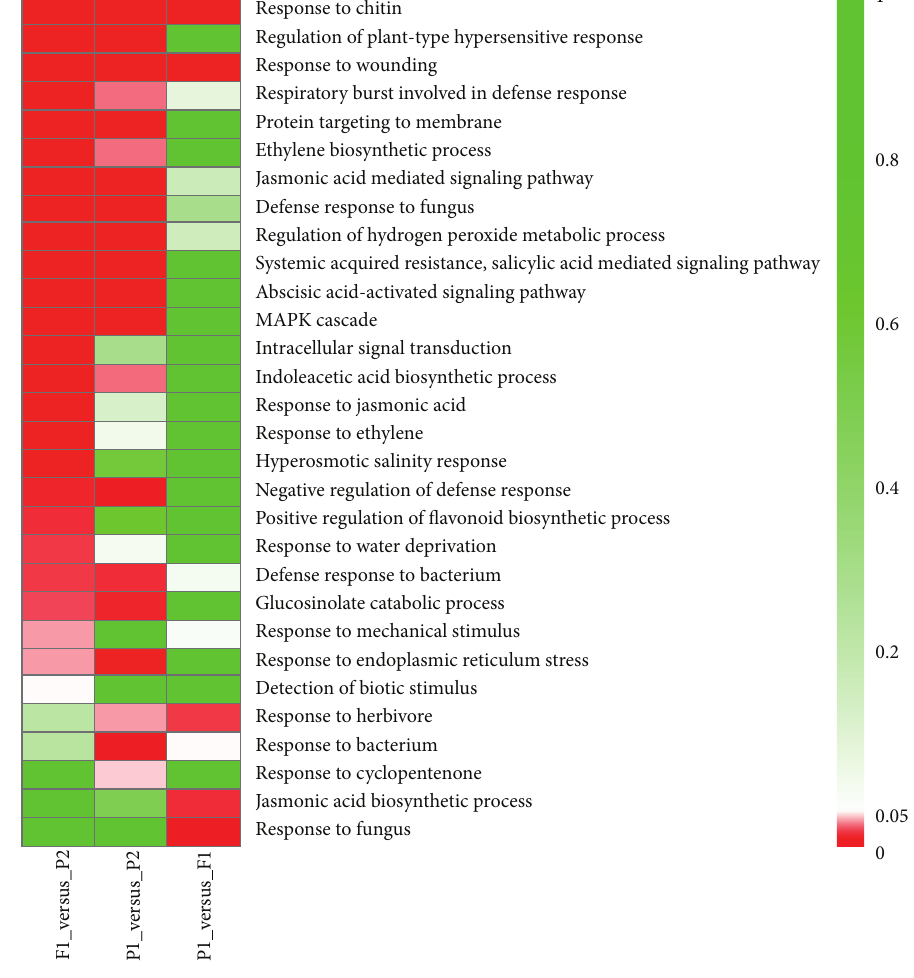
Figure 6: The heat map from GO enrichment analysis of DEGs between the P1, P2, and F1 combinations. Color scale represents 𝑃 values of enrichment